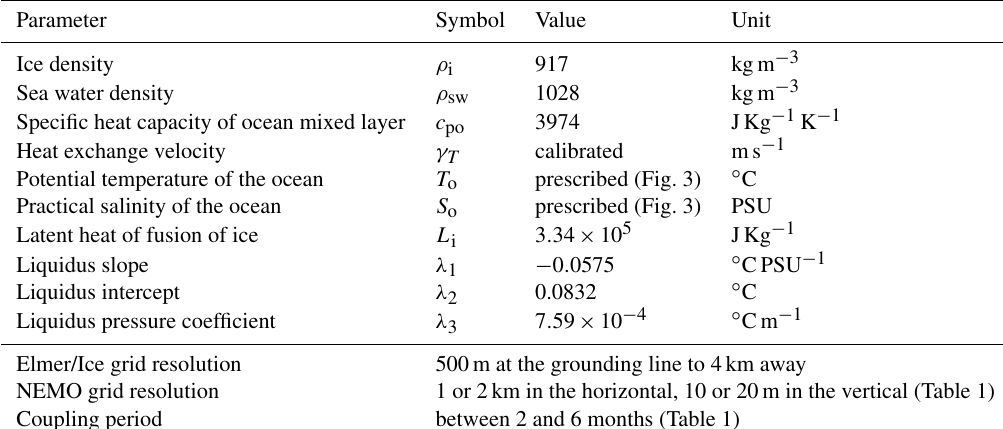
Table 2. Physical parameters, model grid resolutions, and coupling period.